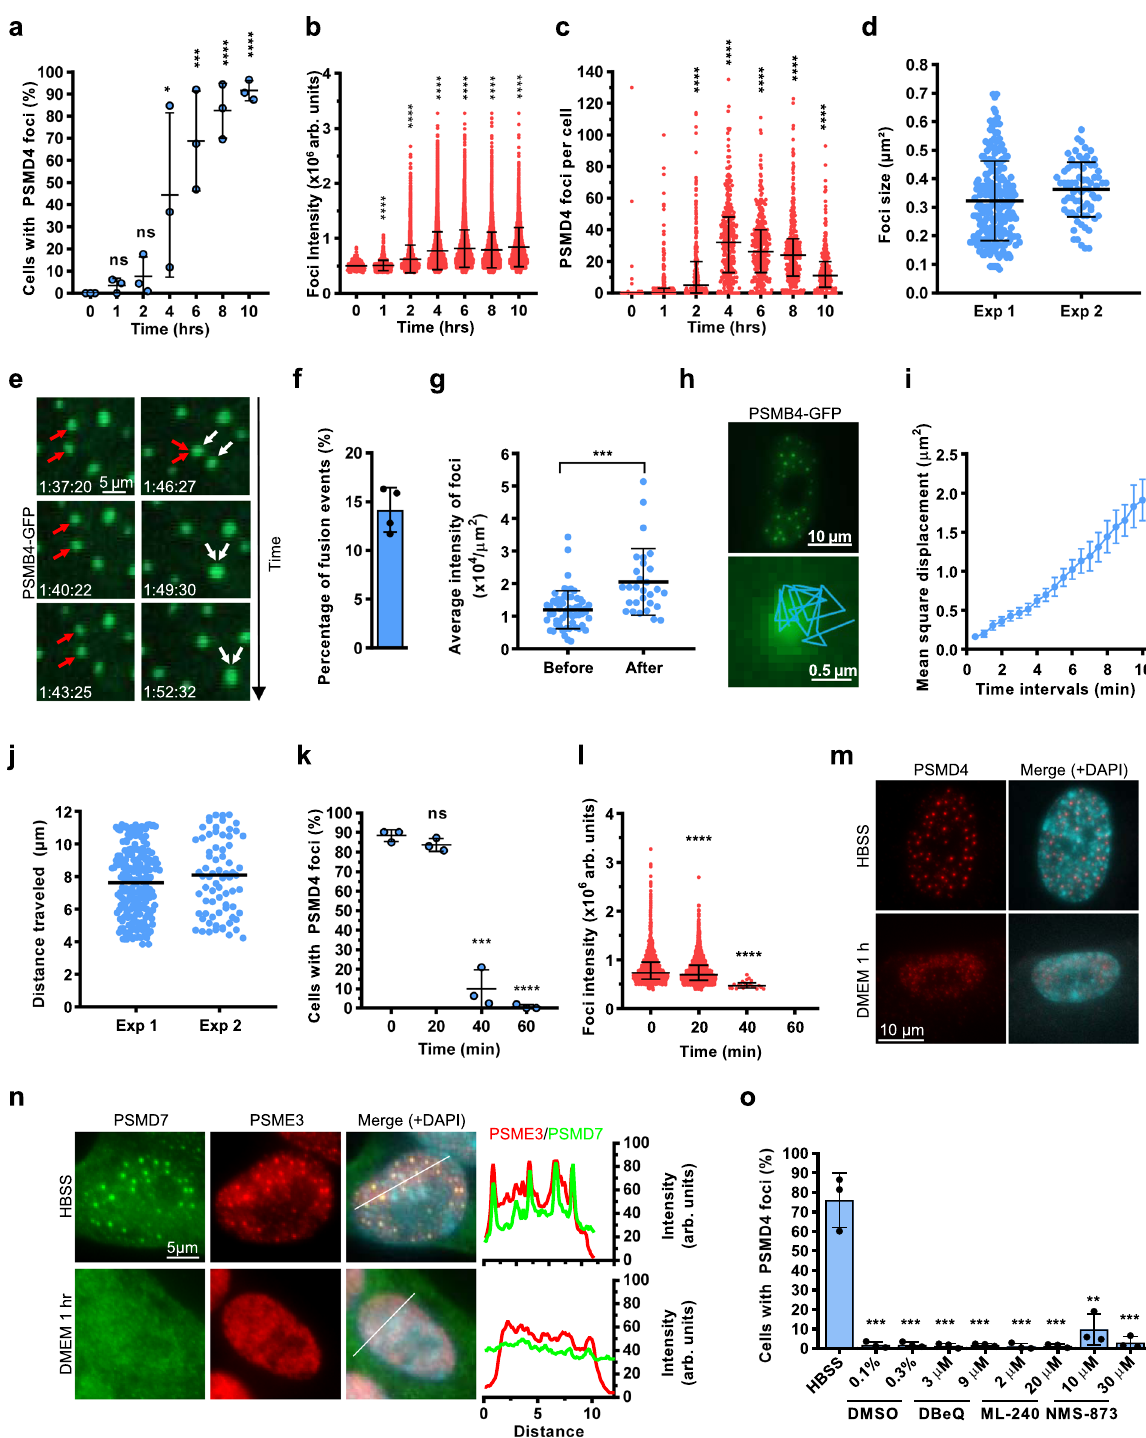
cells by incubation in HBSS for 8 hrs followed by treatment with MG132 in the same solution for 1 hr. Following proteasome inhibition, we observed increased levels of several short-lived nuclear stress-associated transcription factors, including p53, C- FOS, and C-JUN, suggesting that nuclear proteasome is still active under conditions of SIPAN formation (Fig. 10a). Next, we used a Me4BodipyFL-Ahx3Leu3VS (Proteasome Activity Probe) 43 , which accumulates in SIPAN after hydrolysis, and this also sug- gested that the proteasome is active in SIPAN (Fig. 10b).